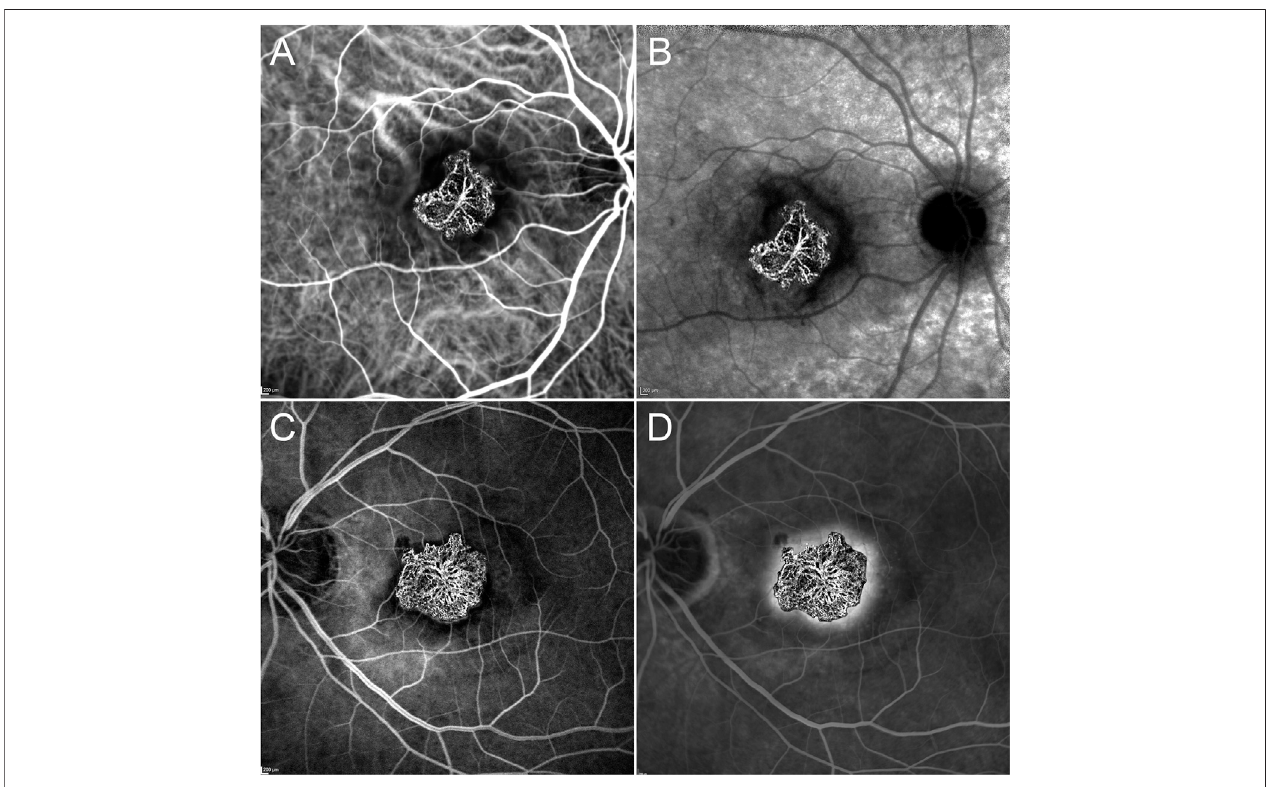
FIGURE3| OCTAvsdye-based angiographyintype1andtype2MNV.OCTAMNVreconstructionoverlapswellwiththeICGAplaqueintheearlyphase (A) butis found tobeconsiderablysmaller than theICGA lesion inthelate phase (B) . Ontheotherhand, type2MNV isofsimilar sizein both OCTA andearlyFAexaminations (C) , maintaining the dimensions even in the late FA phase (D)